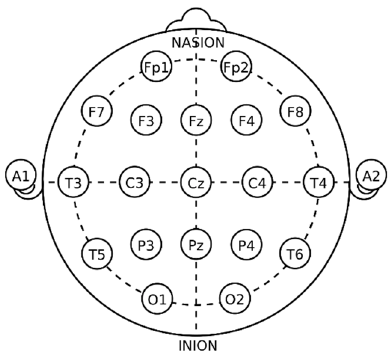
Figure 1. Electroencephalogram (EEG) electrode placement according to the international 10–20 system.